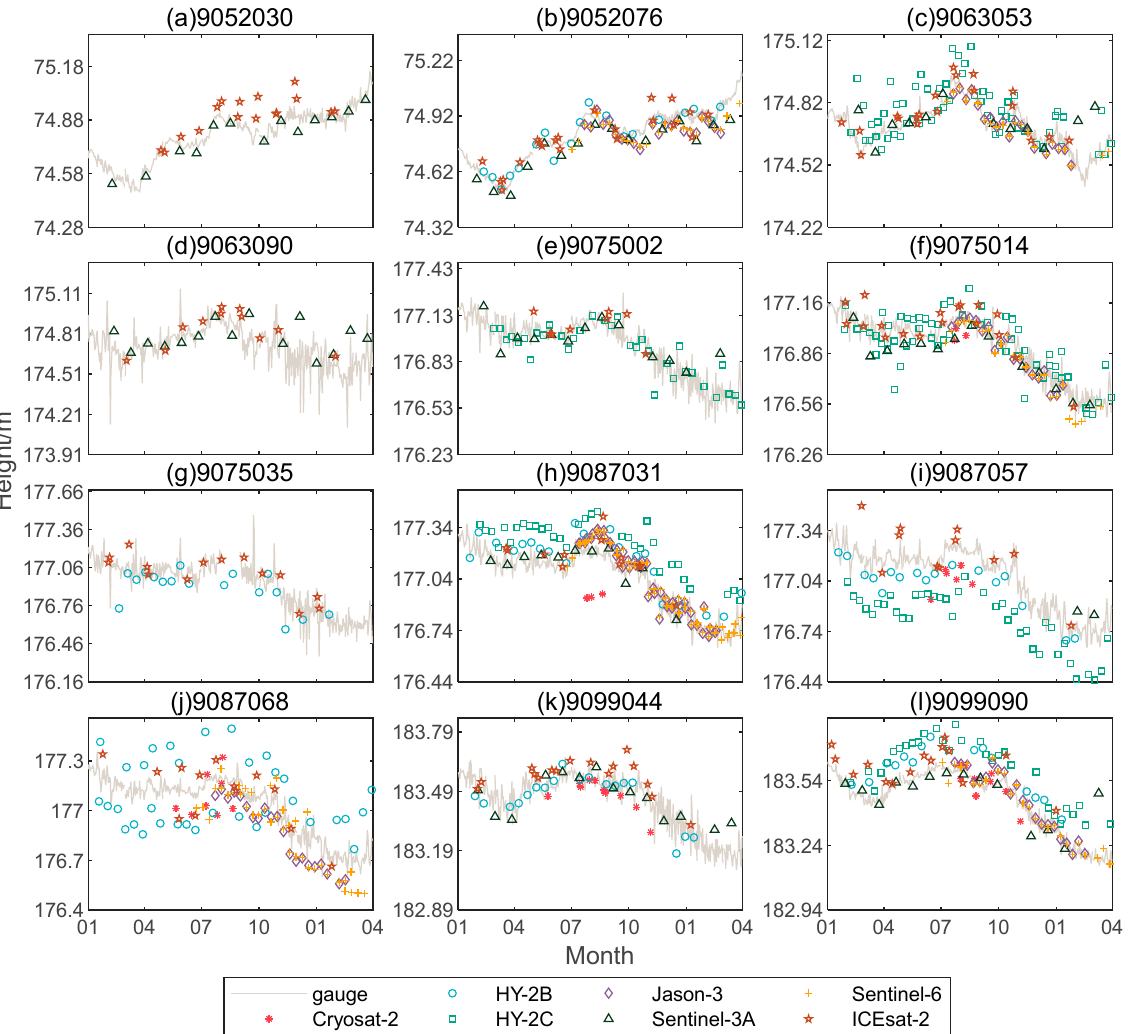
possible to obtain the global inland water level with the high temporal resolution based on the fusion of multi-source altimetry data.